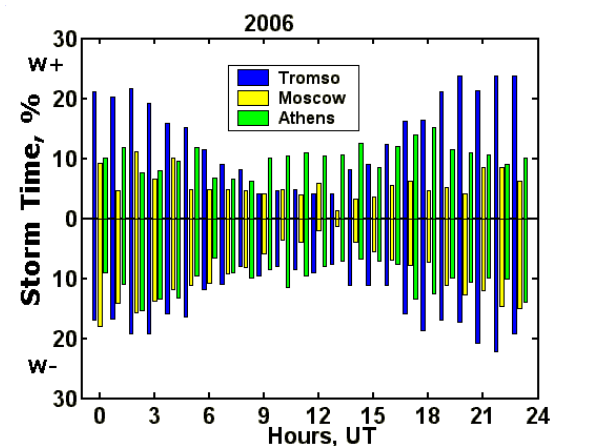
Fig. 7. Seasonal variation of monthly counts of the ionospheric storm times at Sodankyla (lower panel) for actually observed data sets and complete monthly data, including cloned fcF2 values filling the gaps in the observations. The actual number of observed hourly values of foF2 and the complete monthly counts of hours (upper